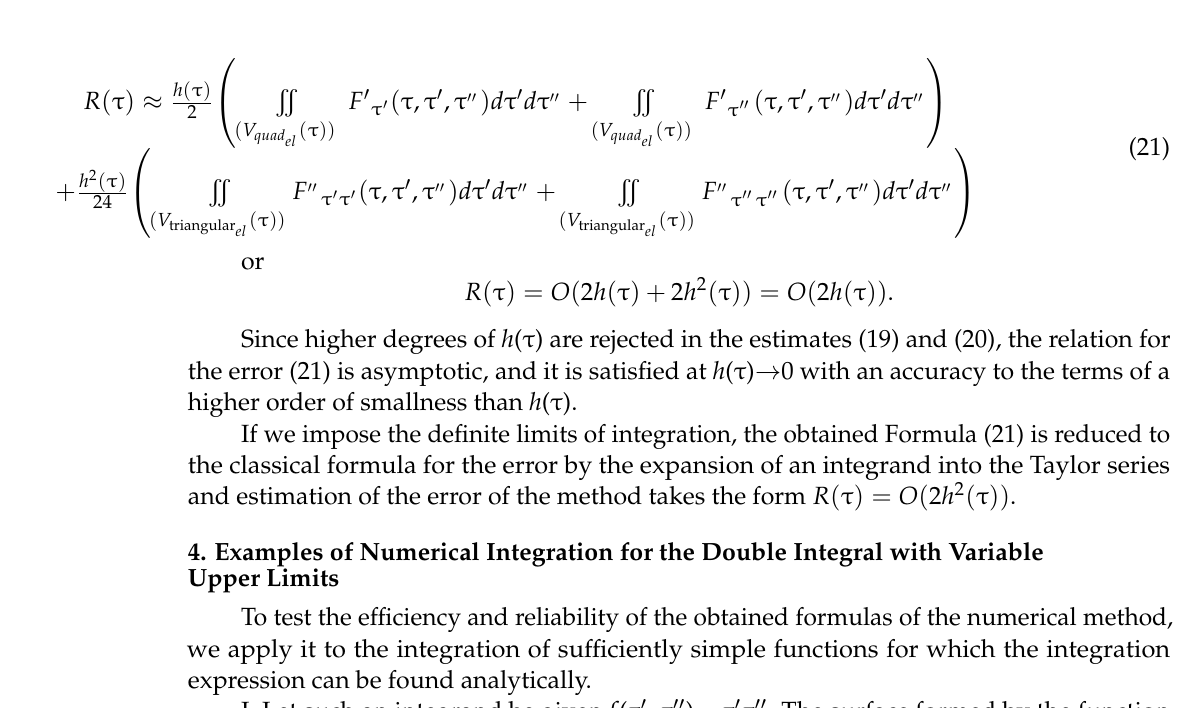
τ τ′ τ′′τ′τ′′τ′ for the case of A. 0 0